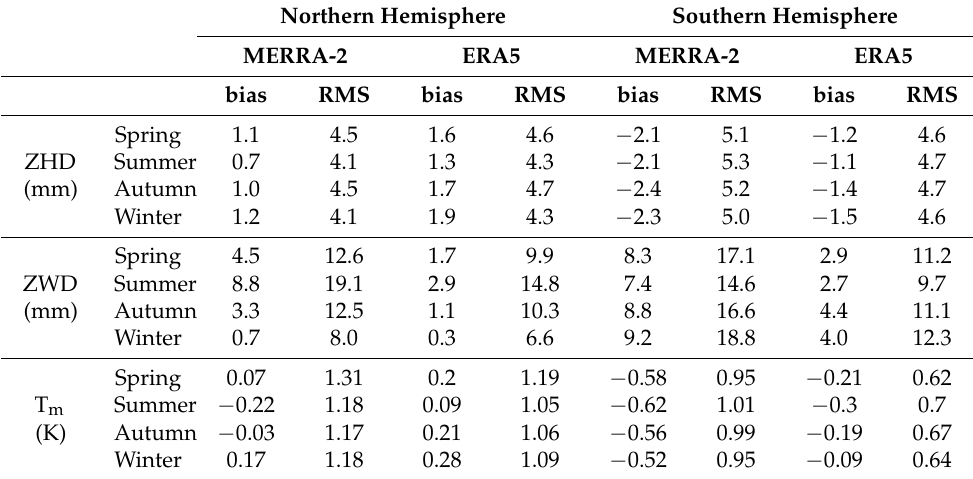
Table 5. Average bias and RMS of ZHD, ZWD, and T m for MERRA-2 and ERA5 pressure-level data in different seasons. Northern Hemisphere Southern Hemisphere MERRA-2 ERA5 MERRA-2 bias RMS bias RMS bias RMS bias